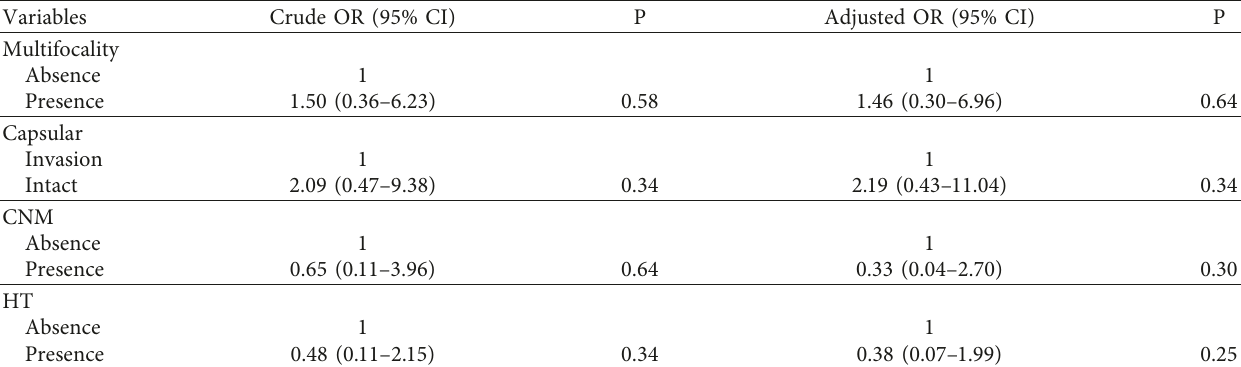
Table 3: Univariate and multivariate analyses between the diameter of the occult lesions and predictors. Variables Crude OR (95% CI) P Adjusted OR (95%